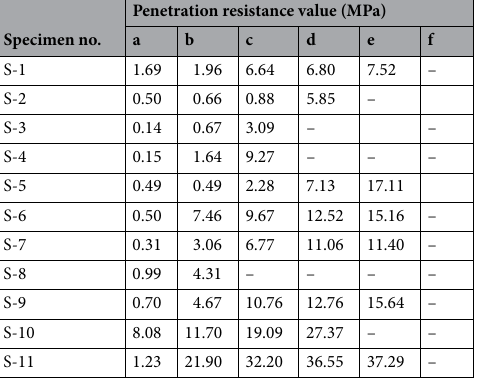
Breccia content